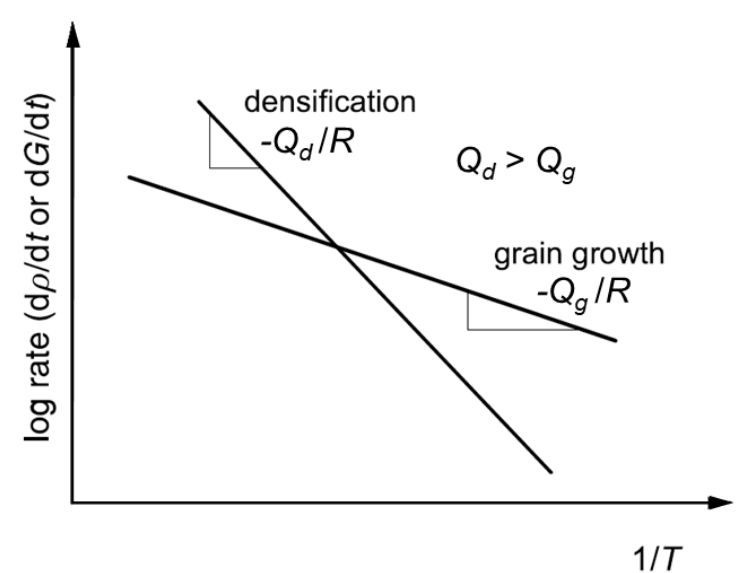
Figure 5. Temperature dependence of densification and grain growth rate for a material in which the activation energy of densification, Q d , is larger than that of grain growth, Q g [1] (reprinted with permission from Elsevier).